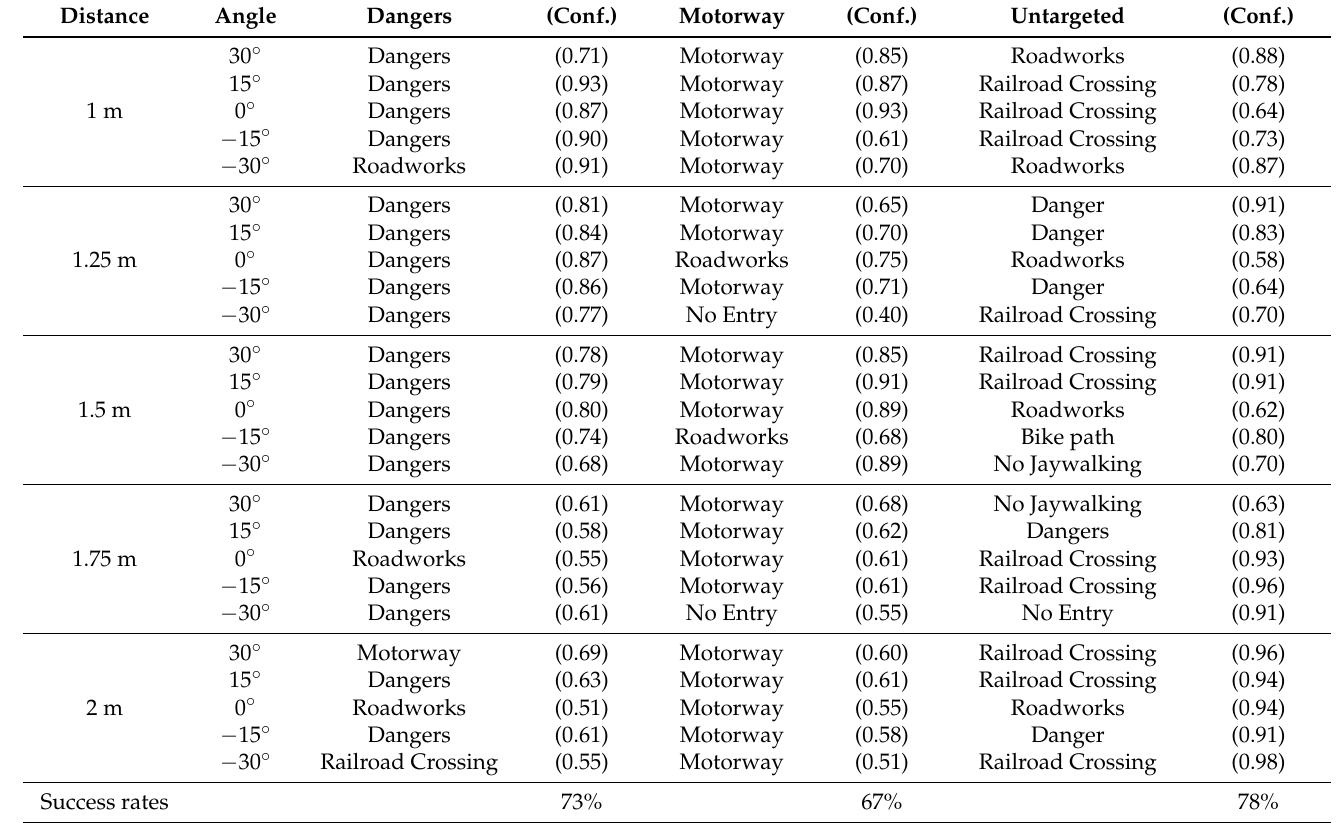
Table 6. The physical-world attack result of ‘Roadworks’ traffic sign mock ups of targeted attack and untargeted attacks with different distances and angles against VGG16.